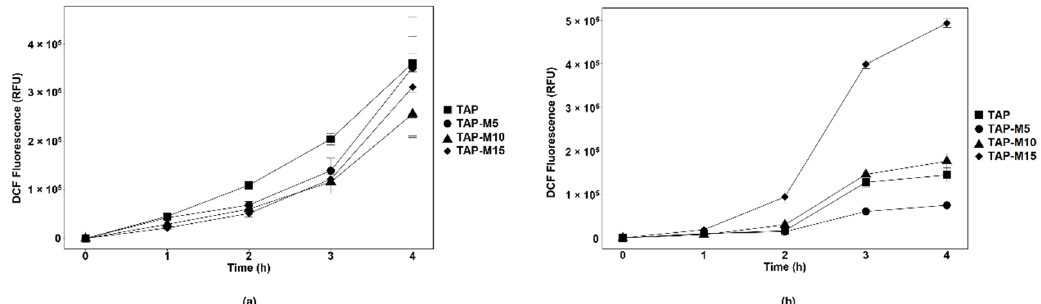
Figure 4. ROS production in Chlamydomonas sp. MACC-216 ( a ) and Chlorella sp. MACC-360 ( b ). Error bars represent standard deviations.